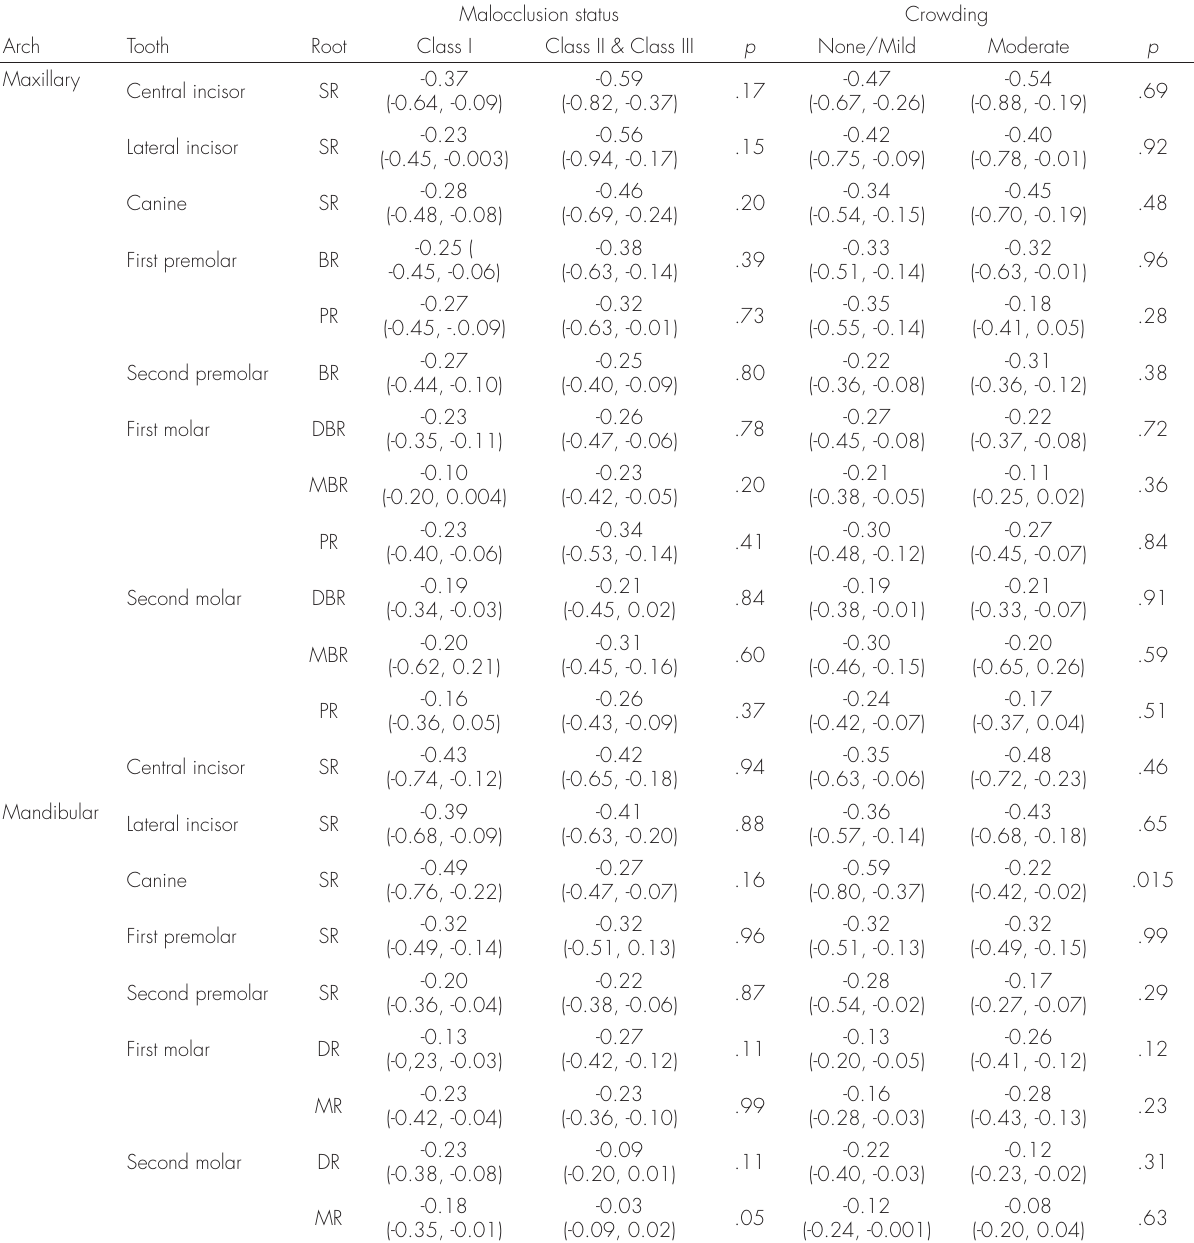
Table III. Average measure of change in tooth length after treatment analysed by malocclusion and crowding